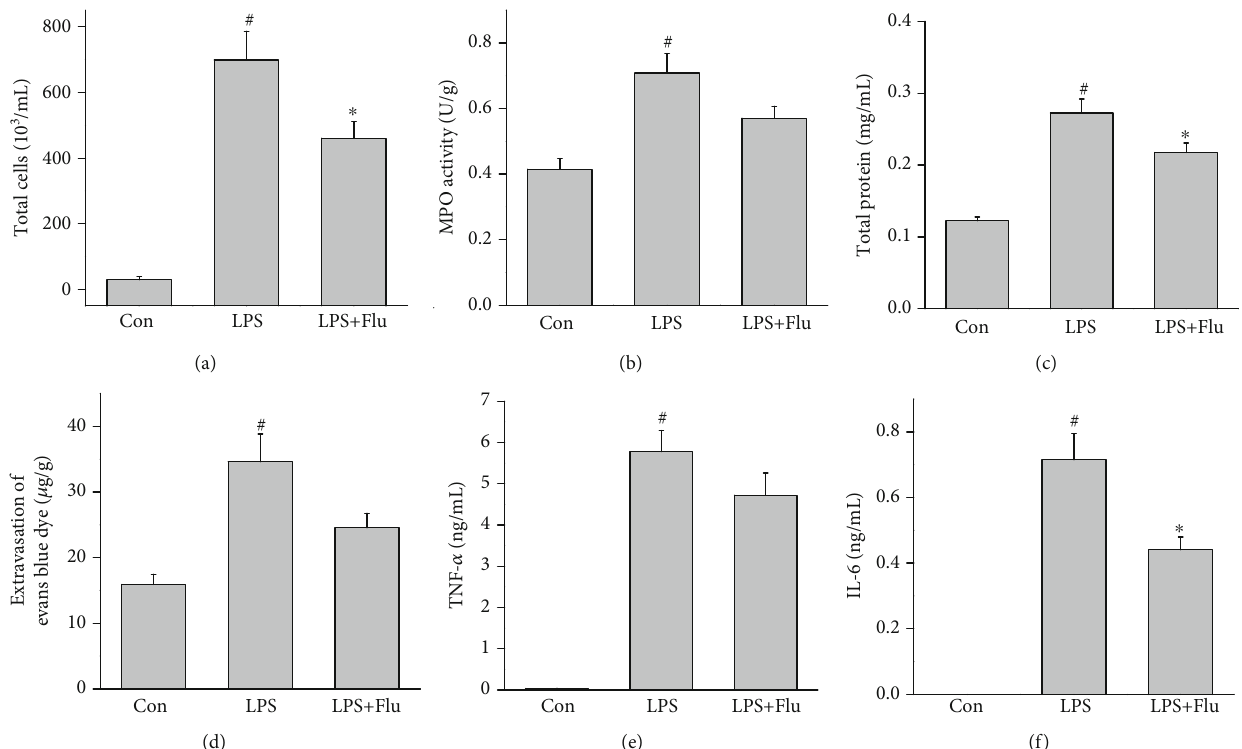
Figure 7: Therapeutic e ff ects of fl unarizine on LPS-induced lung injury. Flunarizine (30 mg/kg) was injected 30 min after LPS exposure, and mice were sacri fi ced 6h after LPS exposure. The total cell counts (a) in BALF, MPO activities (b) in lung tissue, total protein concentration (c) in BALF, extravasation of Evans blue dye (d) in lung tissue, and TNF- α (e) and IL-6 (f) levels in BALF were measured. All values are mean ± SEM ( n = 6 ). # p < 0 : 05 , compared with vehicle-treated control; ∗ p < 0 : 05 , signi fi cant compared with LPS alone; ∗∗ p < 0 : 01 , signi fi cant compared with LPS